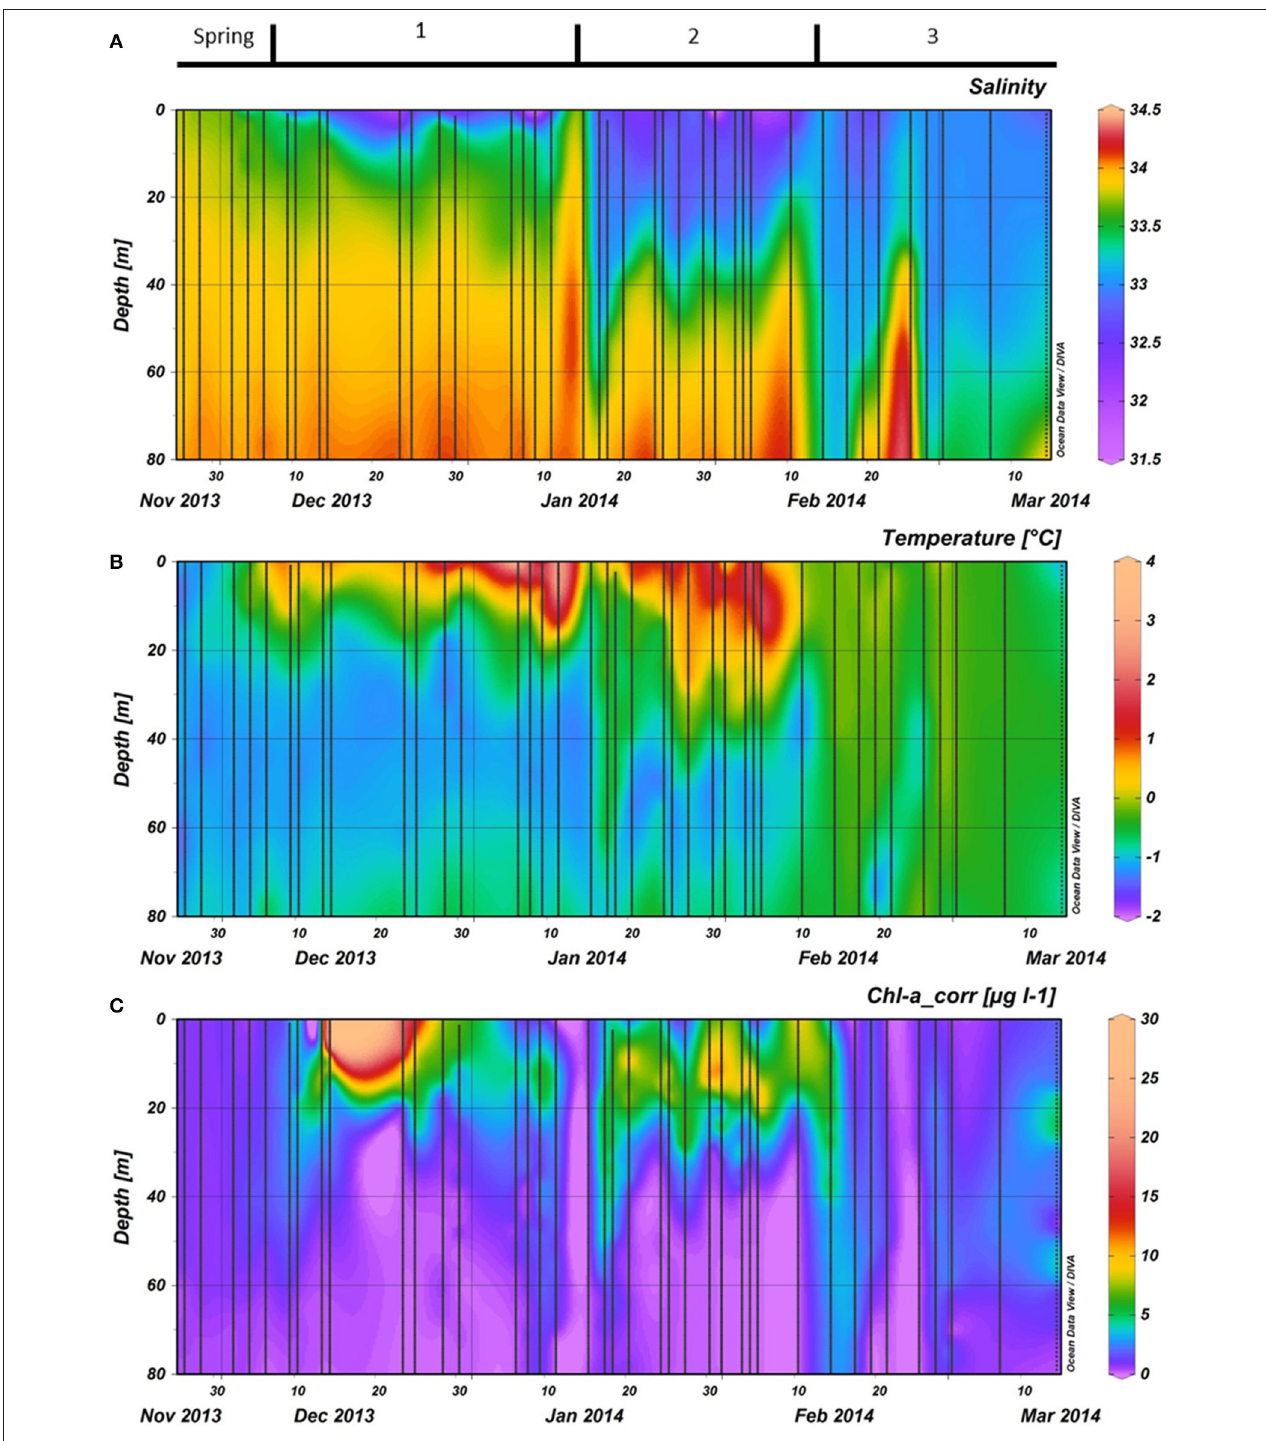
FIGURE 3 | (A) : Salinity, (B) : Temperature, and (C) : Phytoplankton biomass as measured by fluorescence during the vertical CTD casts. Phytoplankton biomass fluorescence was calibrated against chlorophyll a measurements with HPLC and corrected for quenching in top layer using the chlorophyll estimates. All data were collected during the 2013–2014 season at the RaTS site. Period 1 starts on December 6th, period 2 on January 15th and period 3 on February 10th.